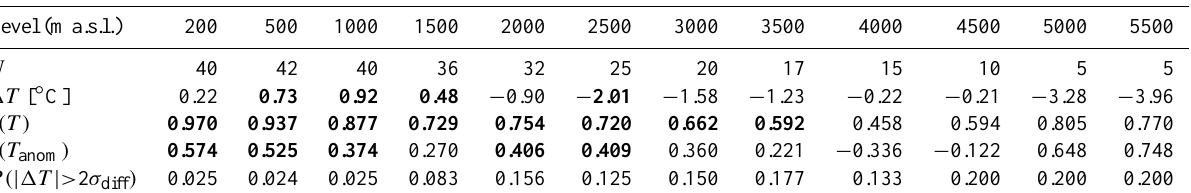
Table 2. Results of the comparison of temperature between observations onboard the SMS Planet and 20CR. 1T is the mean difference between 20CR and the observations, T anom refers to the anomalies from NNR climatology, r is the correlation coefficient, P stands for probability, and P ( | 1T | > 2 σ diff ) is the fraction of differences outside the interval ± 2 σ diff . Bold numbers indicate statistical significance ( p -values < 0.05 for two-sided tests, paired t-test in the case of the bias). Level (ma.s.l.)